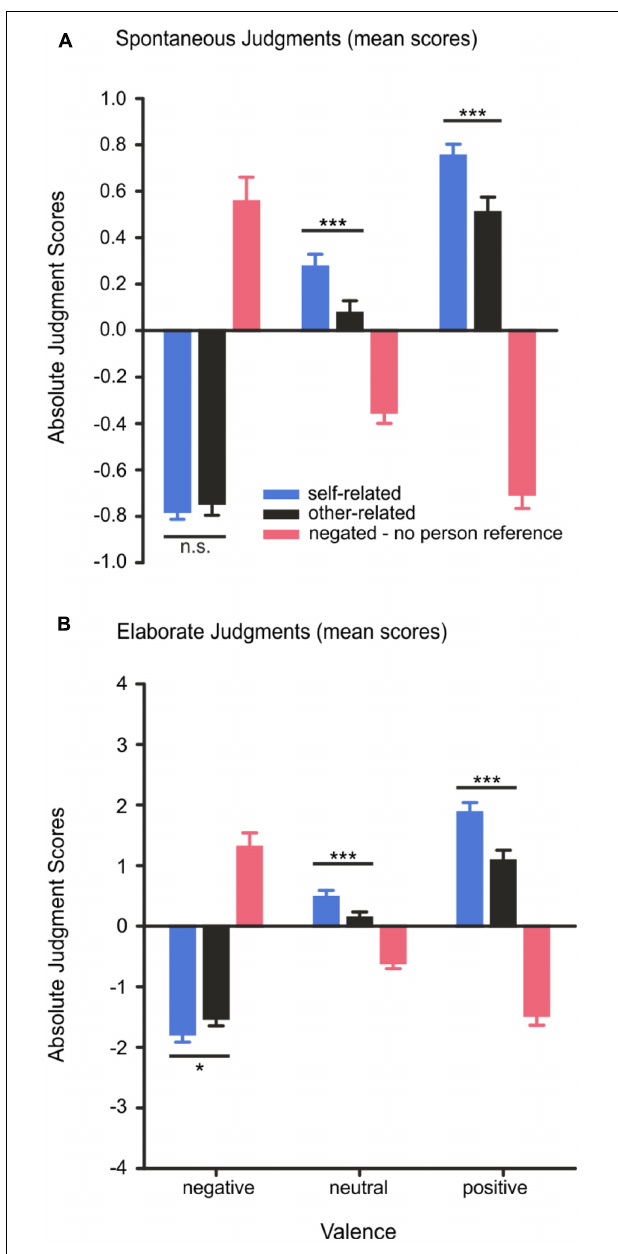
FIGURE 3 | (A,B) Spontaneous and elaborate valence judgments. For the spontaneous judgment, subjects had to press one of three buttons corresponding to either negative (–1), neutral (0), or positive (1) valence. In the elaborate judgment, subjects had to verbalize a number on a 9-point scale for their rating to indicate the intensity of their feelings. The number ‘one’ represents very negative, the number ‘five’ neutral and the number ‘nine’ very positive. Error bars depict SEM. n.s. p > 0.1, ∗ p < 0.05, ∗∗∗ p < 0.001, FDR